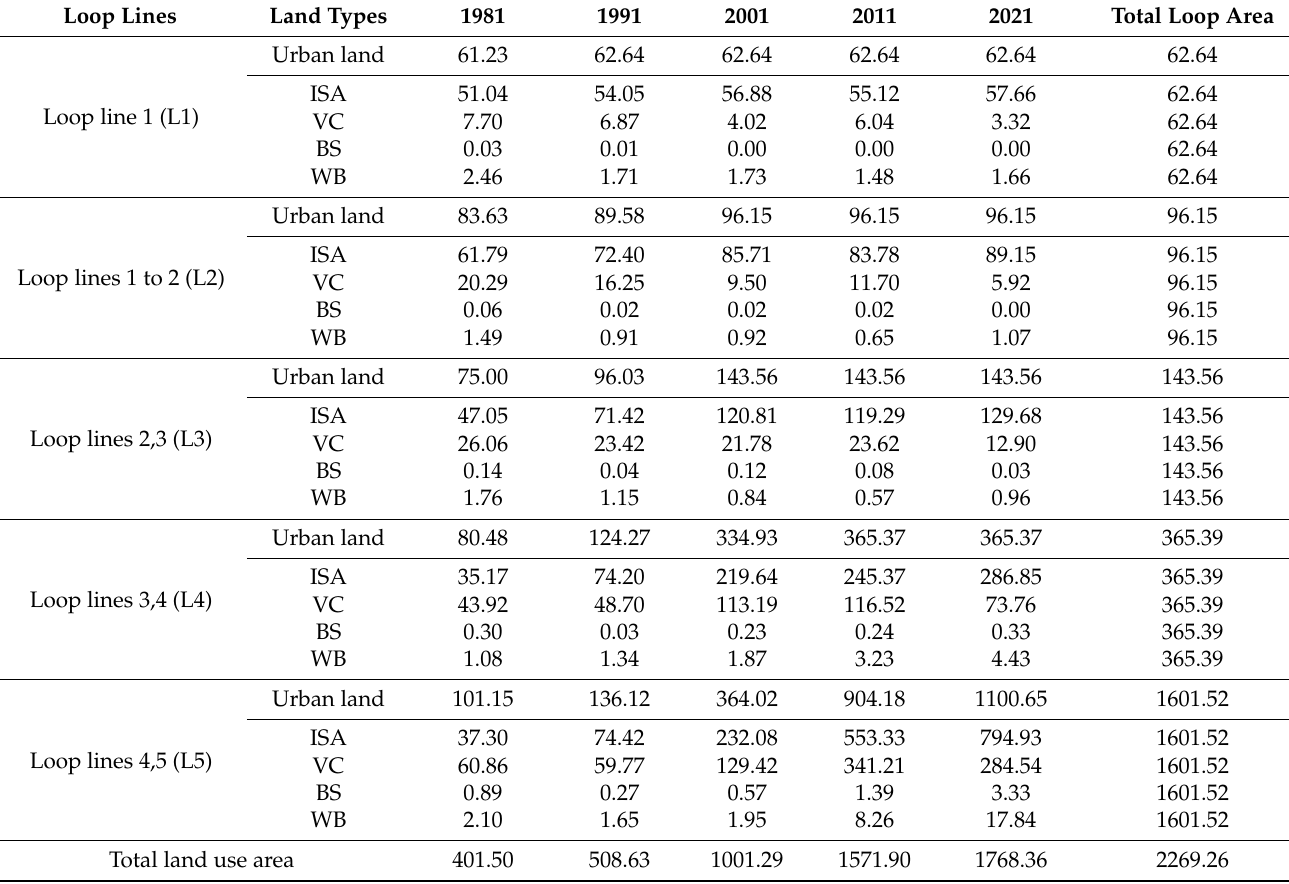
Table 6. Urban land and its structural covers within each loop lines in the study area during the period of 1981–2021 (Area unit: km 2